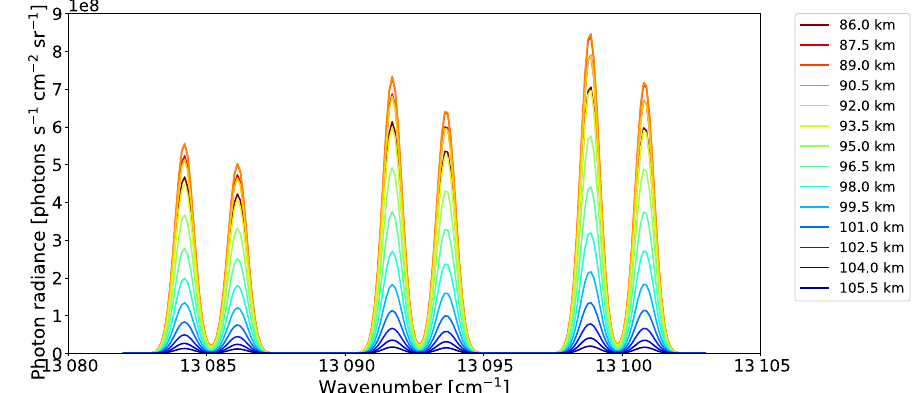
Figure 5. Modelled limb spectral photon radiance for different tangent altitudes. The background atmosphere is taken from the HAMMONIA model, around 30 ◦ N and 88 ◦ E for 22:00 local solar